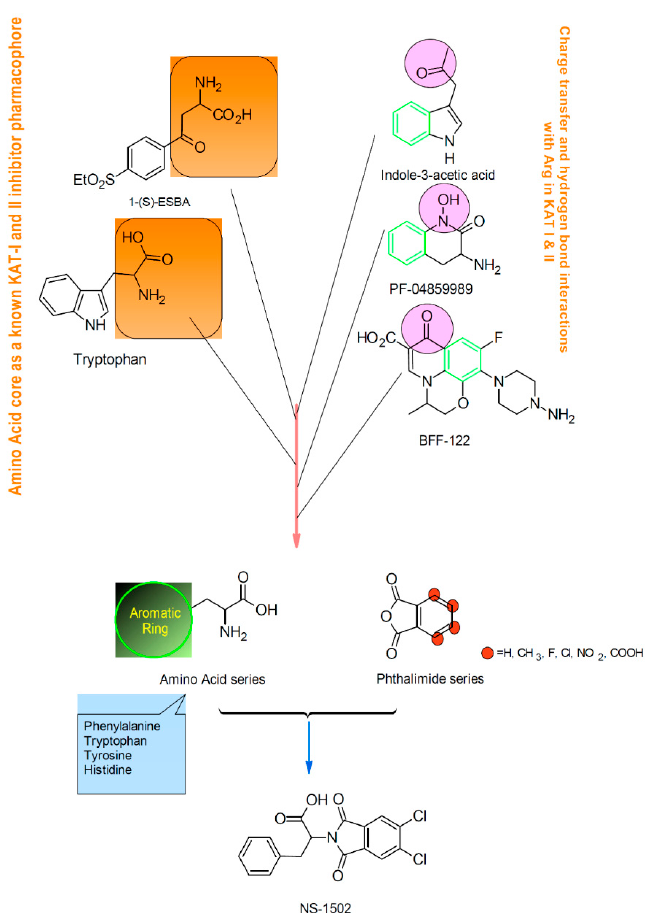
Figure 3. NS-1502 was designed on the basis of existing KATs inhibitors and compounds involved in the kynurenine pathway. The left branch of the design is on the basis of the similarity of (S)-ESBA to KYN, and tryptophan, the right side of the design scheme is based on the pharmacophore of the most potent available KAT-2 inhibitors (BFF-122 and PF-04859989) and general KATs inhibitor (indole-3-acetic acid).